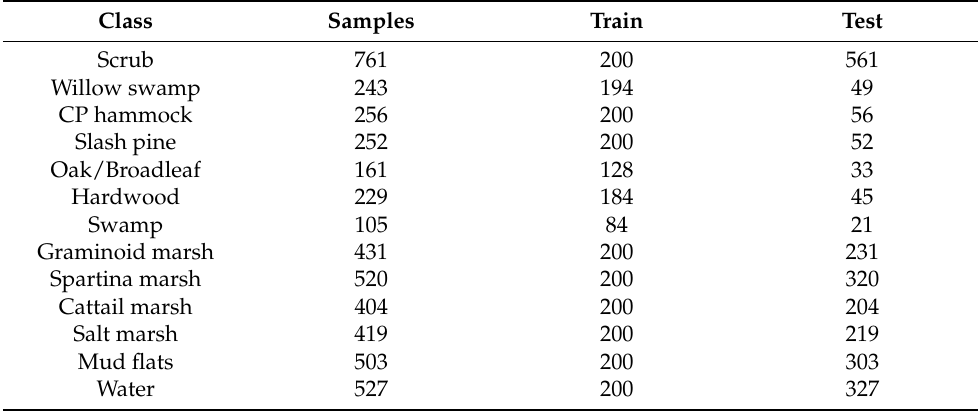
Table 7. Sample information for the Kennedy Space Center dataset.